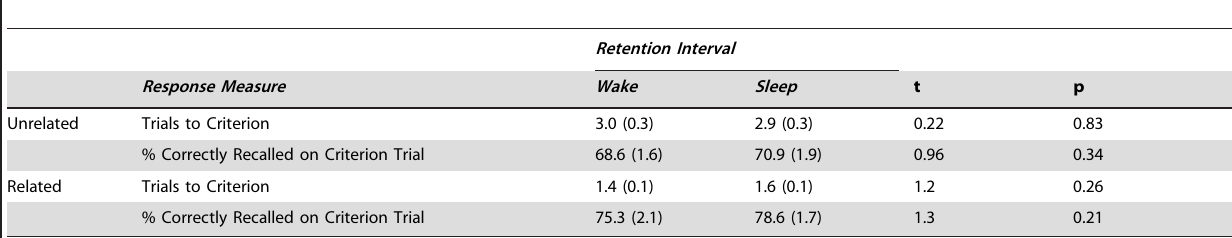
Table 2. Performance at training on unrelated and related paired-associates in the 12 hour groups (Wake, Sleep).